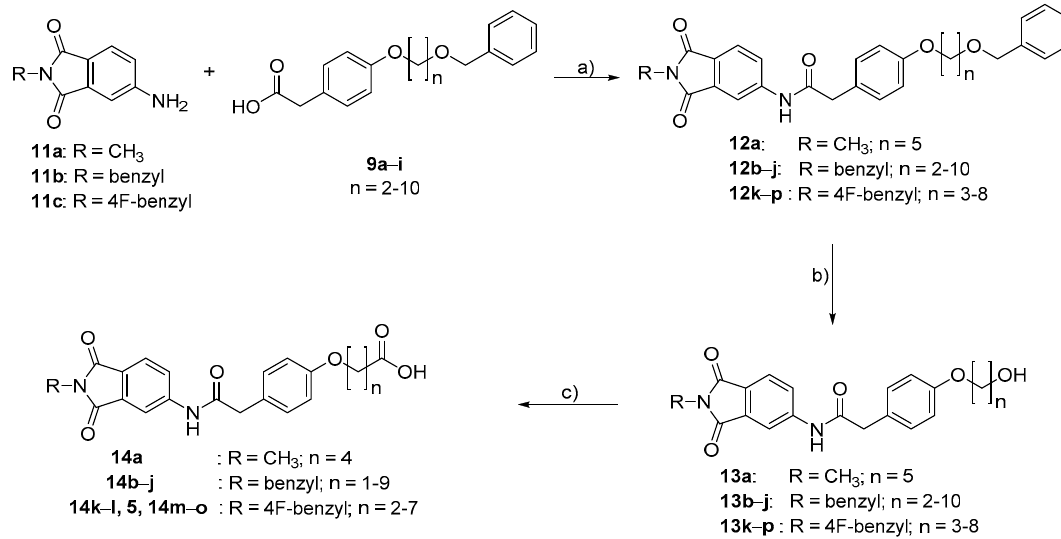
Scheme 2. Synthesis of the test compounds 5 and 14a-o . Reagents, conditions and yields : ( a ) SOCl 2 ,